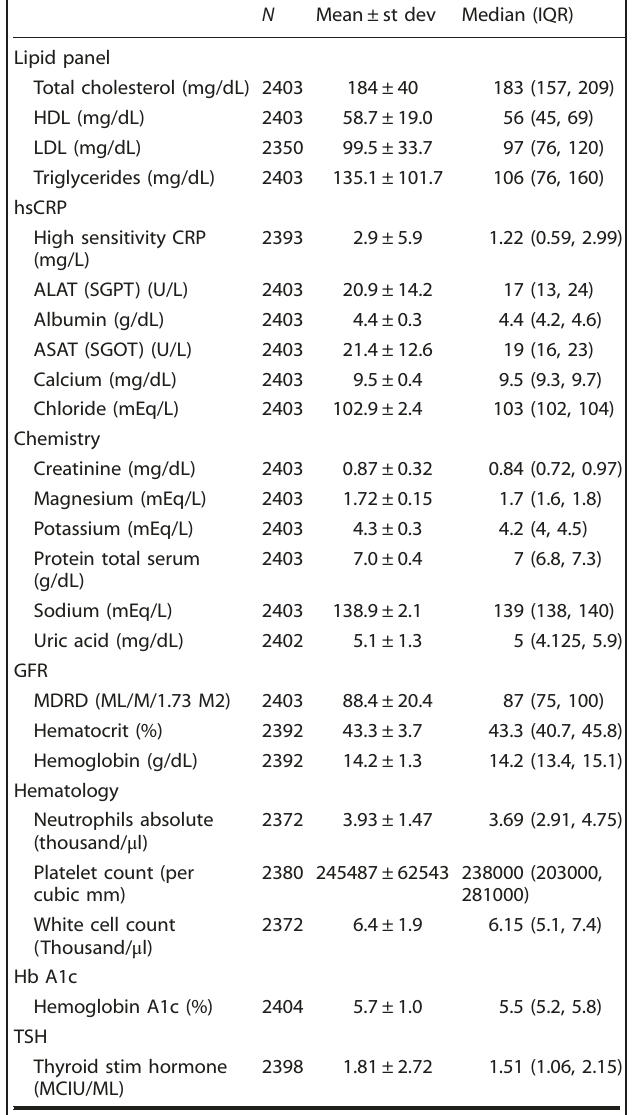
Table 4. Molecular